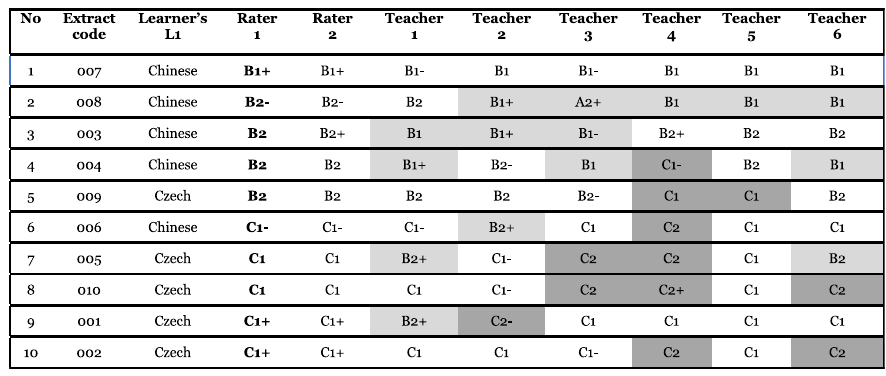
Table 9 Holistic CEFR levels awarded by two experienced raters and six teachers of